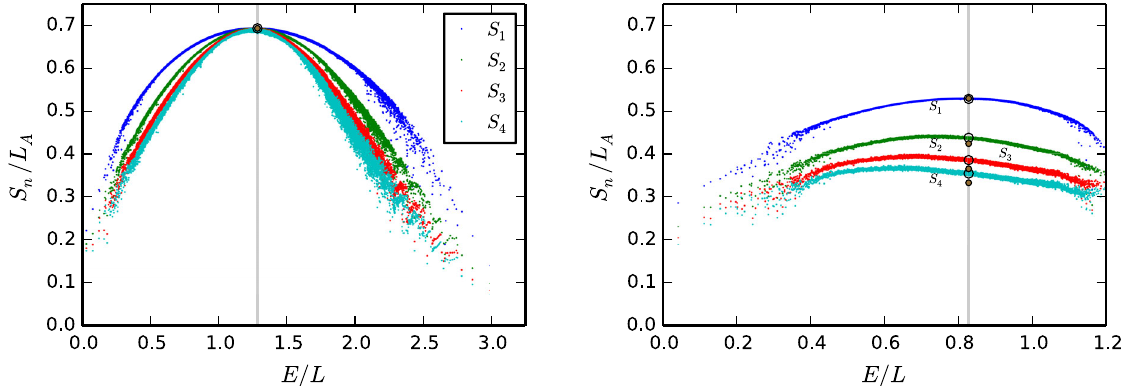
FIG. 1. Entanglement entropies S 1 through S 4 for a model with no conservation law [left panel, given by Eq. (30) at L ¼ 21 ] and a model with particle-number conservation [right panel, given by Eq. (22) at L ¼ 27 , with filling N ¼ 6 ]. We use the parameters mentioned in the text to place each model at a nonintegrable point. In each case, we consider eigenstates in the k ¼ 1 sector, with 4 . The grey vertical line denotes infinite temperature (point of maximum S subsystem size L A ¼ theoretical predictions for the entanglement entropies there. The brown markers denote the theoretical values of the entropies in the limit L =L → 0 , as given by Eqs. (26) and (27). , L → ∞ while L A A